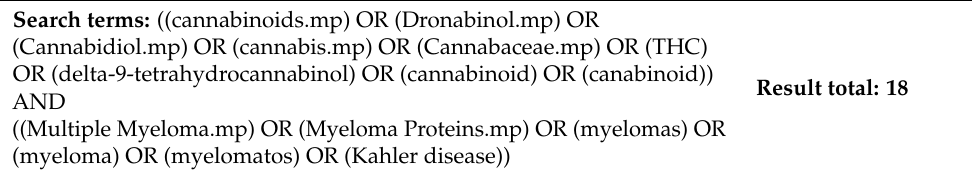
Table 1. Search terms for OVID Medline (conducted on 23 July